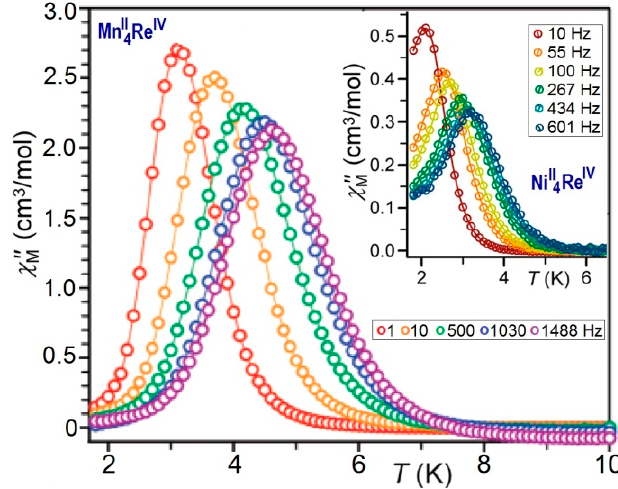
Figure 3. Variable-temperature imaginary parts of ac magnetic susceptibility data for 4 and 9 (inset) obtained in a 4 Oe oscillating field at different frequencies [3,4].